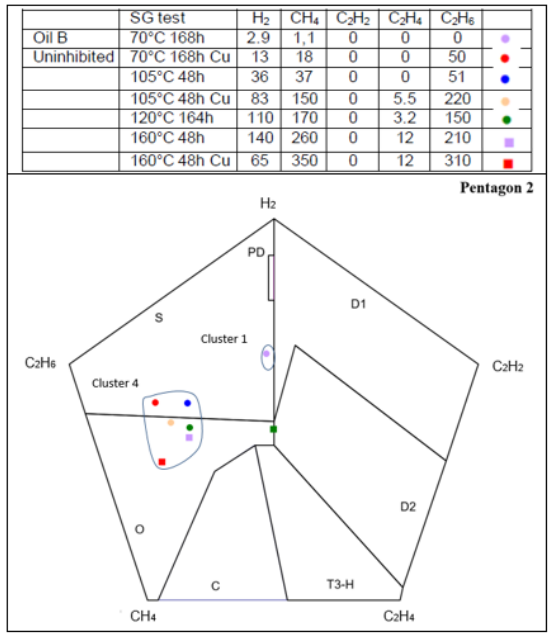
Figure 5. SG of uninhibited mineral oil B during laboratory SG tests at the FKH, in Clusters 1 and 4.